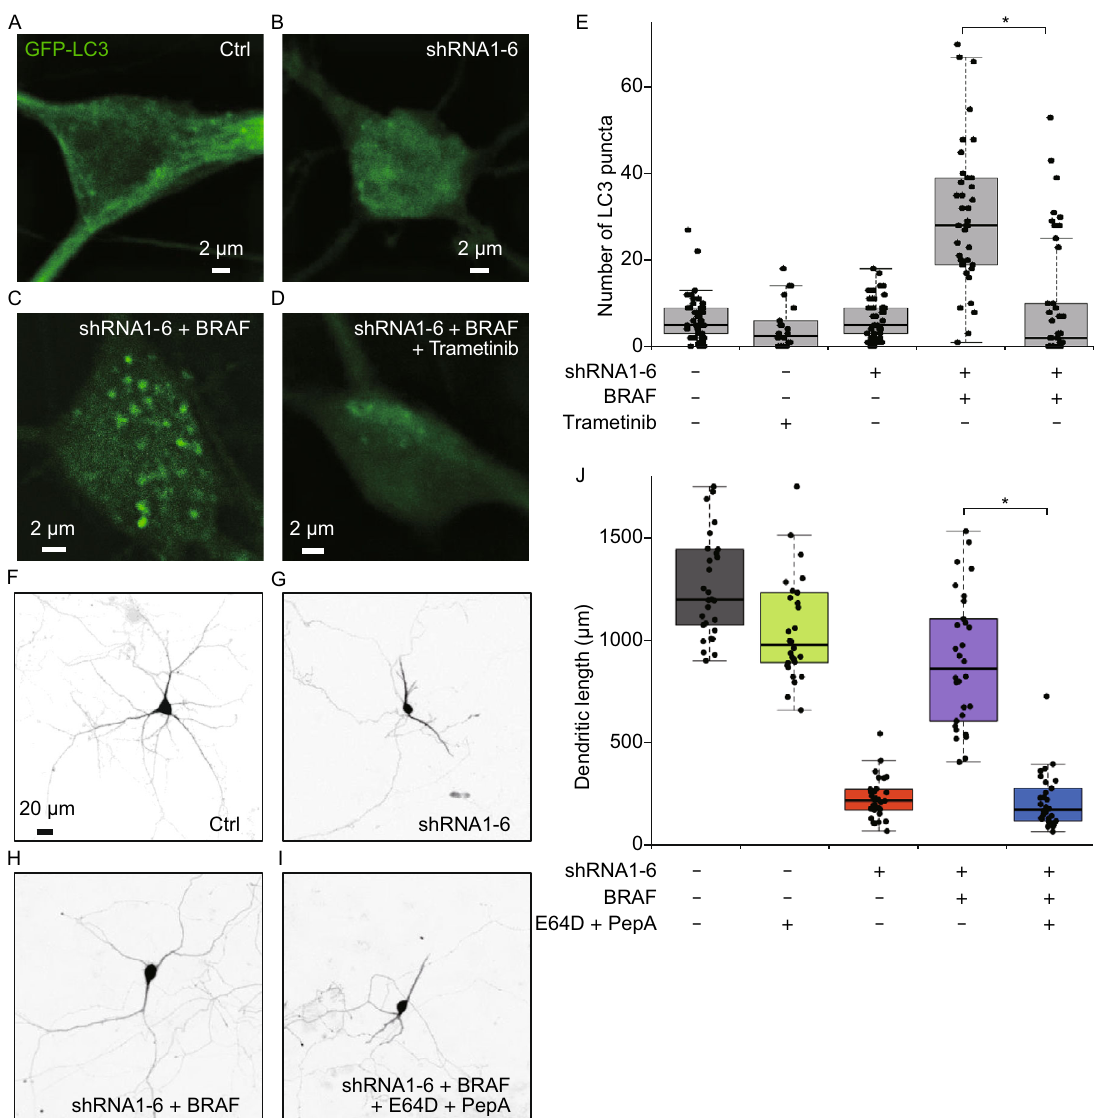
Figure 4. BRAF overexpression protects against DYNC1I1 de fi ciency induced dendritic atrophy by activating MEK- dependent autophagy. (A – D) BRAF overexpression enhances protective autophagy, which is MEK dependent. Primary hippocampal neurons are co-transfected GFP-LC3 with blank vector, shRNA1-6, shRNA1-6 and BRAF treated without or with 100 nmol/L of MEK inhibitor trametinib at DIV6, cultured additional 5 days and imaged at DIV11. Autophagosomes (green puncta) are labeled with GFP-LC3. All photos of GFP-LC3 are imaged with confocal microscope and further deconvolved for clarity. The scale bars represent 2 μ m. (E) Scatterplots with boxplots show the number distribution of GFP-LC3 puncta in the soma of neurons transfected with control vector treated without ( n = 41) or with 10 nmol/L of trametinib ( n = 22), shRNA1-6 ( n = 48), shRNA1-6 co- transfected with BRAF treated without ( n = 39) or with 100 nmol/L of trametinib ( n = 44). (F – I) Lysosomal protease inhibitors (E64D and pepstatin A) can inhibit the protective role of BRAF in dendritic atrophy caused by DYNC1I1 knockdown with shRNA1-6. Neurons are transfected and treated without or with 1 μ mol/L of E64D and pepstatin A at DIV6, cultured additional 5 days and imaged at DIV11. The scale bars represent 20 μ m. (J) Scatterplots with boxplots show the total dendritic length distribution of neurons transfected with control vector treated without ( n = 29, gray) or with 1 μ mol/L of E64D and pepstatin A ( n = 30, green), shRNA1-6 ( n = 30, red), shRNA1-6 co-transfected with BRAF treated without ( n = 30, purple) or with 1 μ mol/L of E64D and pepstatin A ( n = 30, blue). *, P